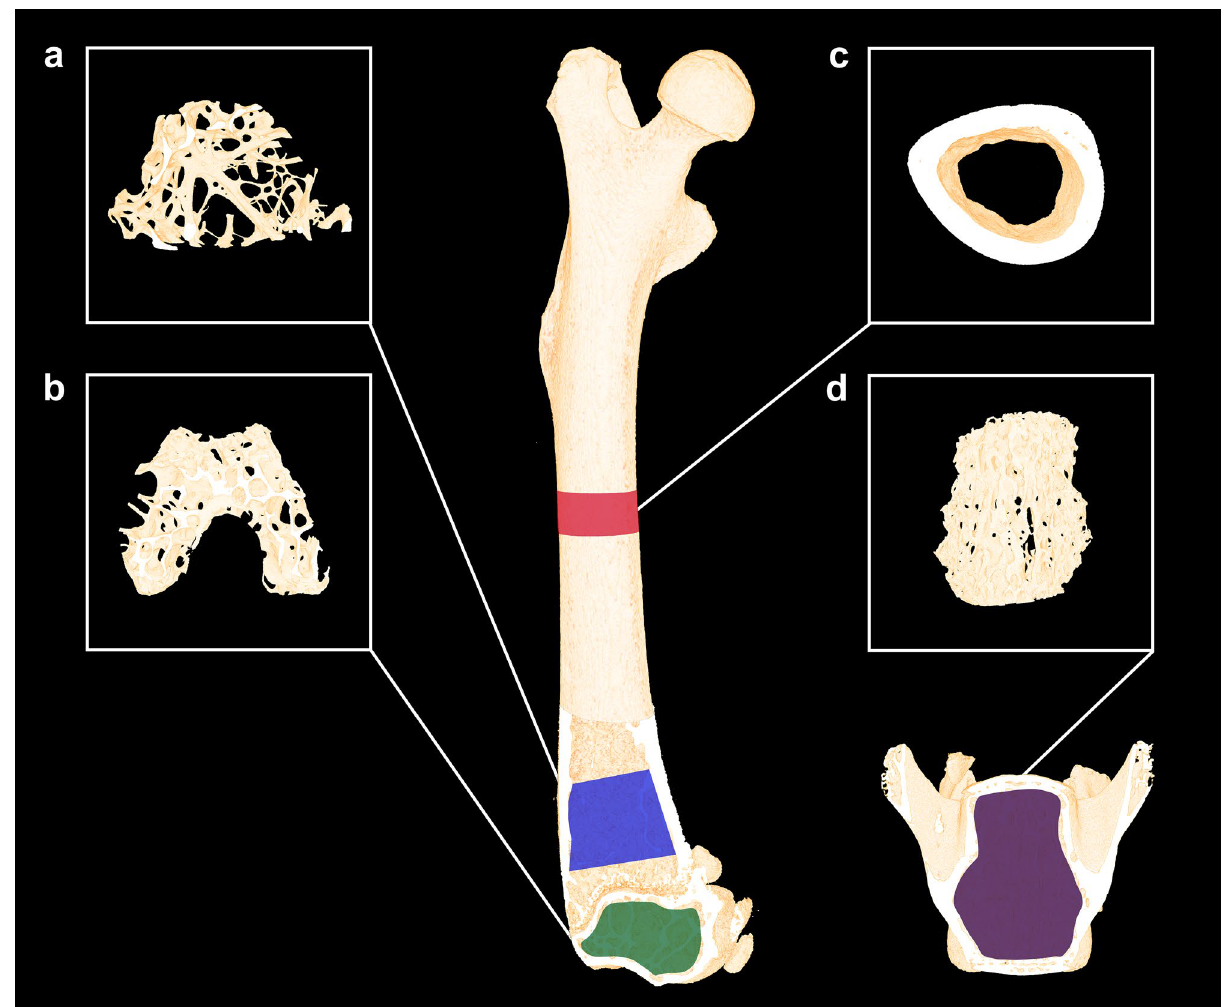
Figure 1. Skeletal sites investigated with μCT using a voxel size of 3.5 μm. ( a ) Blue represents the 1,000-μm-high volume of interest (VOI) at the distal femoral metaphysis. ( b ) Green represents the VOI at the distal femoral epiphysis (approximately 490-μm-high). ( c ) Red represents the 820-μm-high VOI at the femoral mid-diaphysis. ( d ) Purple represents the VOI at the L4 vertebral body (approximately 2000-μm-high). Dimensions are not to